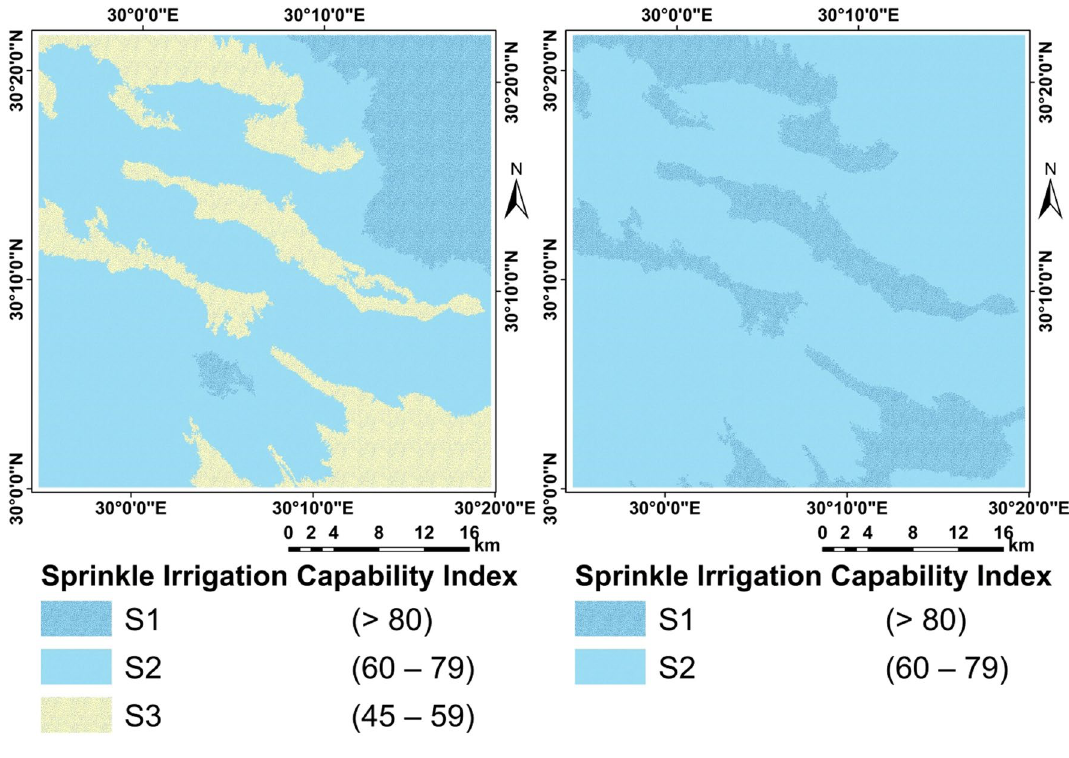
Figure 15. Irrigation